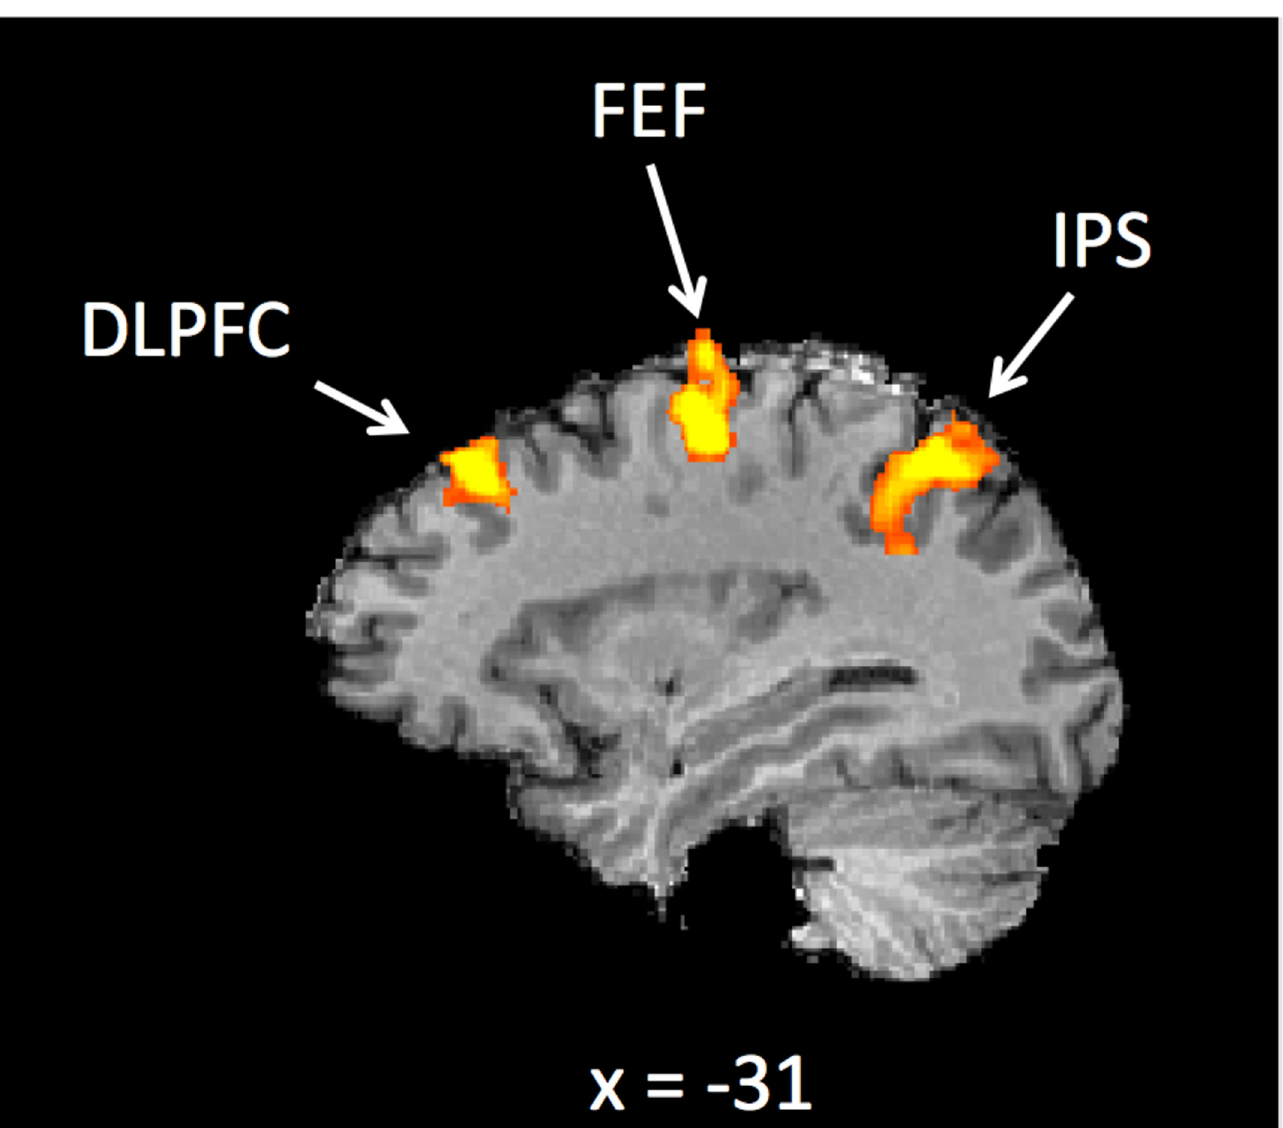
Fig 2. Locations of the DLPFC, FEF and IPS in one representative subject. Executing a saccade (pro-saccade, anti-saccade) was used as an event to functionally identify the six ROIs (DLPFC, FEF, IPS in each of the two hemispheres). These regions are consistent with those localized by DeSouza et al (2003) and the Talairach coordinates are shown in Table